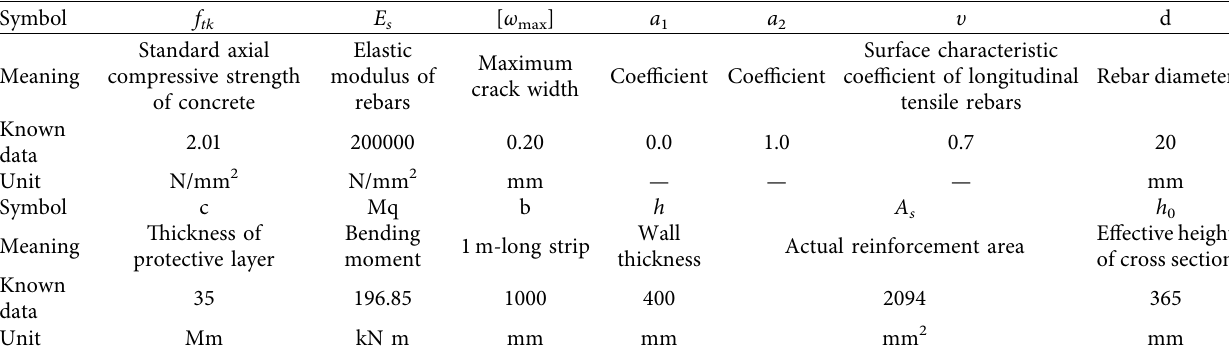
Table 2: Known data used to compute the maximum crack width.